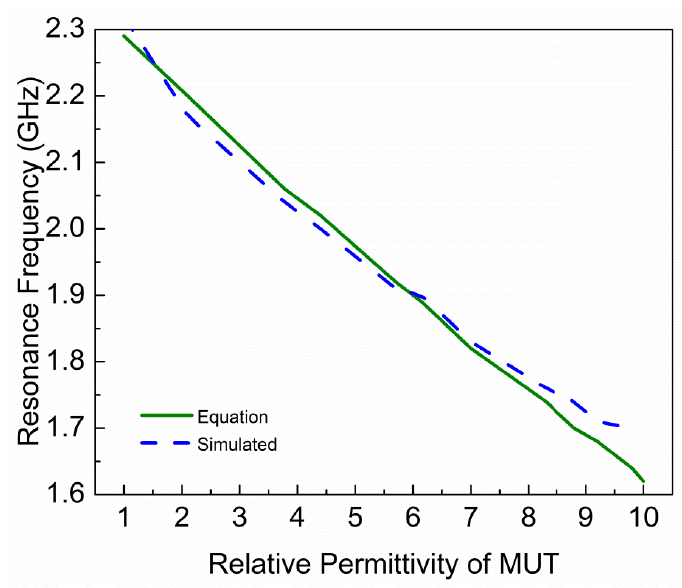
Figure 13. Relative permittivity of MUT versus resonance frequency of the sensor obtained by EM simulation and Equation (14). Table 4. Relative permittivity evaluation using measured result.